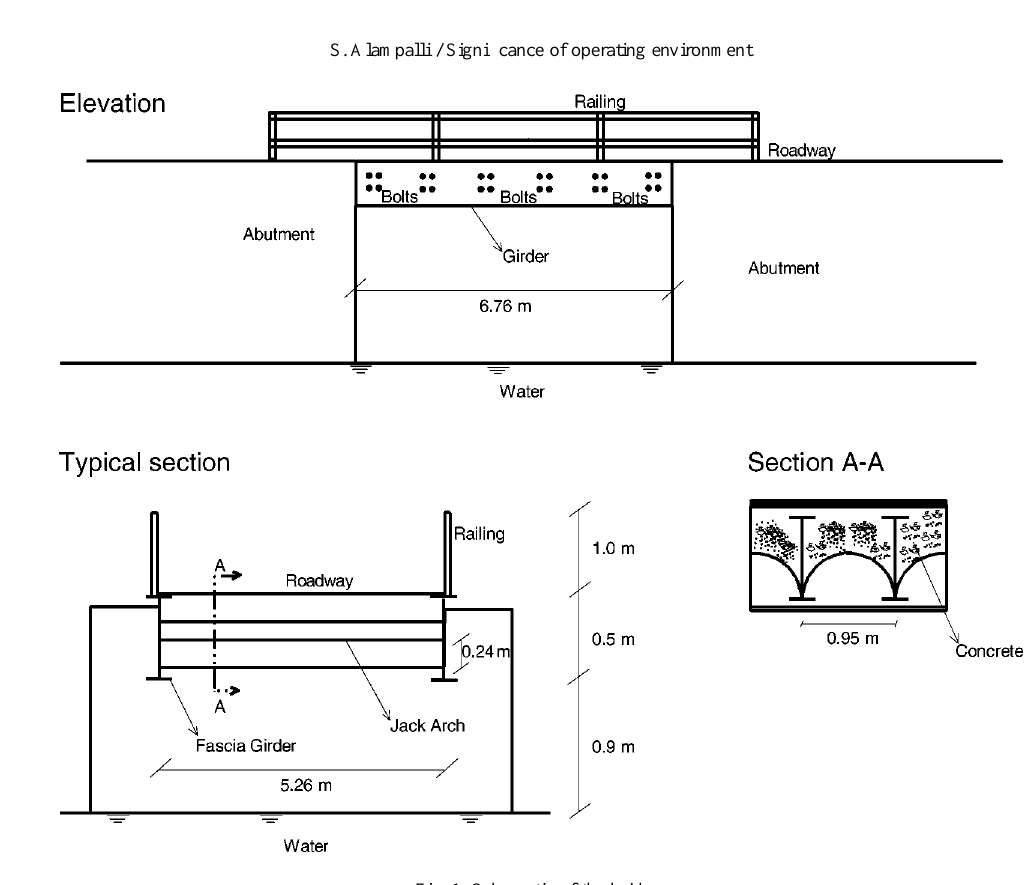
Fig. 1. Schematic of the